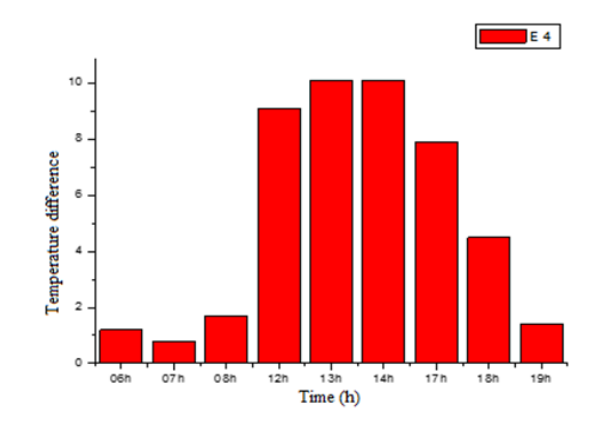
Figure 14. Changes of the internal, external temperatures and humidity during the day.